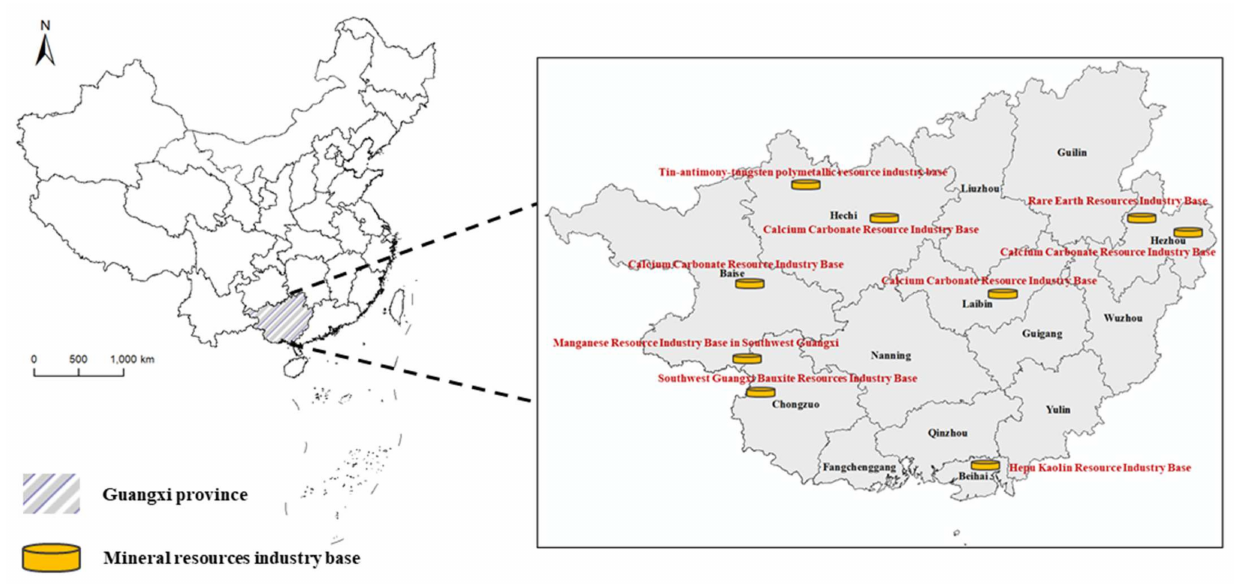
Figure 1. Location of the study